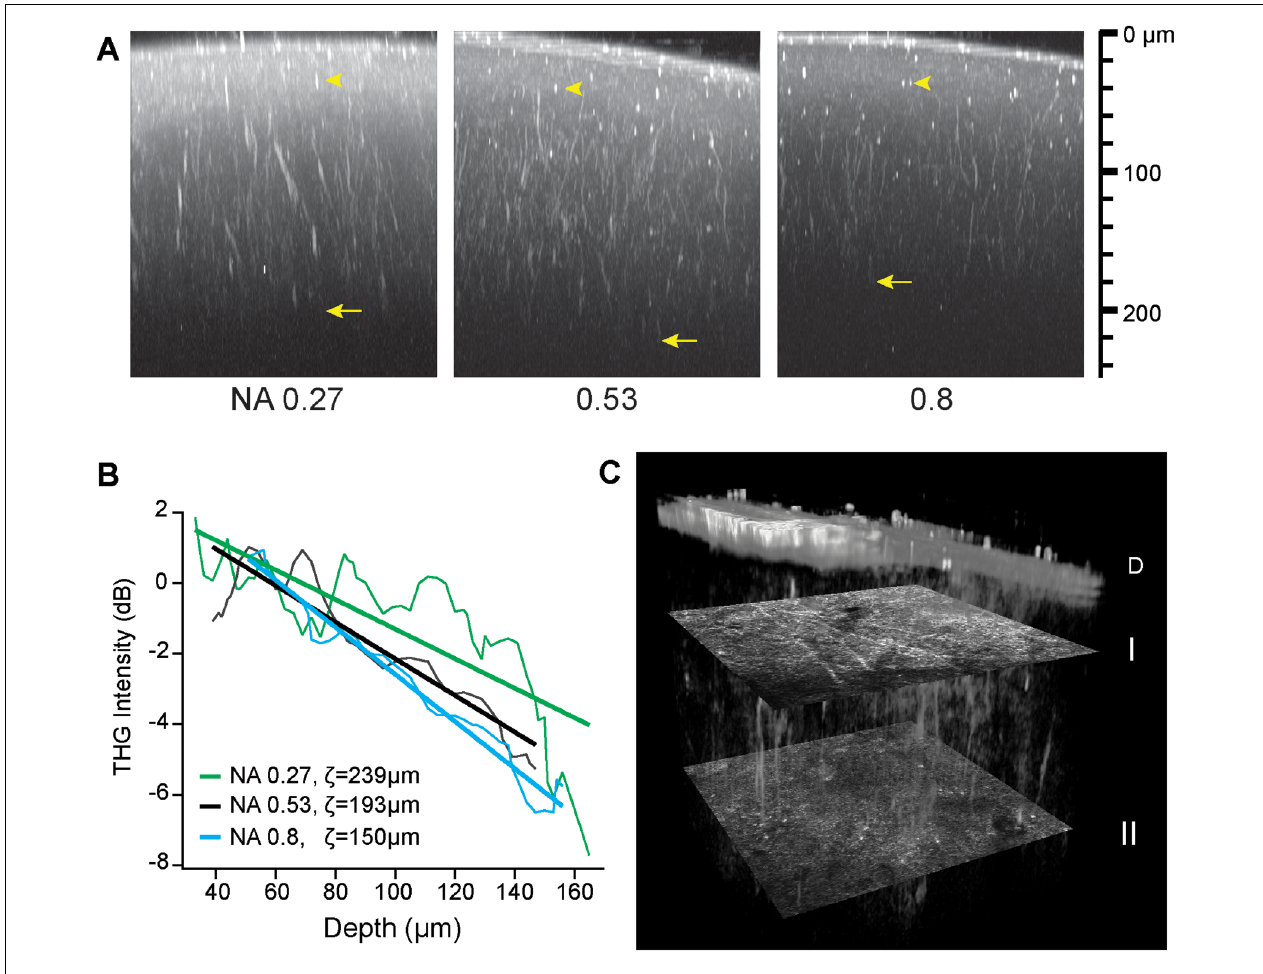
FIGURE 3 | The depth of THG imaging of the intact mouse brain. (A) Characterizing the resolution (arrowheads) and depth (arrows) of ex vivo imaging. Maximum-intensity projection is shown for three effective NAs on the logarithmic scales. (B) Decreasing THG intensity with depth at a rate depending on numerical aperture (NA). The normalized THG intensity from radial myelinated fibers (average of N = 6) and the best fit to a linear model log (cid:104) I/I 0 (cid:105) = (z 0 − z)/ ζ . (C) Cortical myelin imaged in a live animal. Volumetric rendering of a region (151 µ m × 151 µ m × 186 µ m) shows distinct distribution of tangential and radial fibers at depths of 43 and 134 µ m below the dura D (transverse sections I and II,